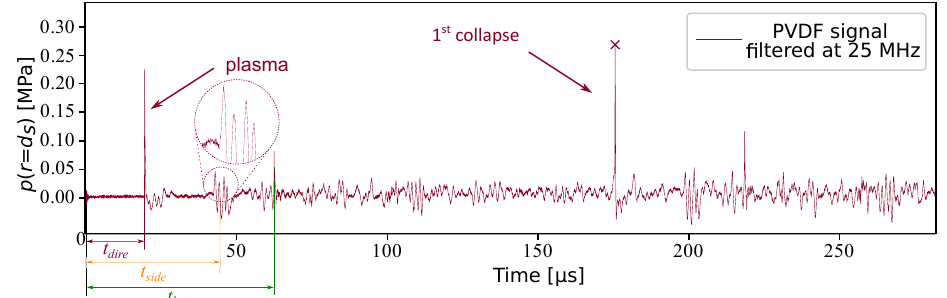
Figure 5. Quantitative measurement by a PVDF sensor for γ = 36.4. The red cross is the maximum values of the pressure wave generated by the first collapse of the